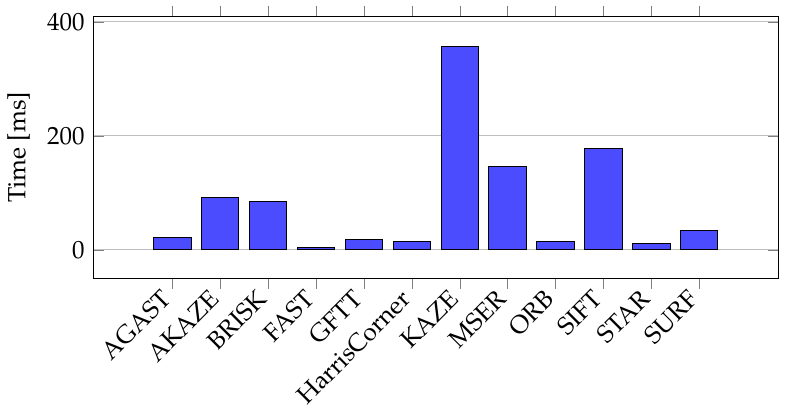
Figure 6. Average time taken for keypoint detection in all images from the Oxford University Database.